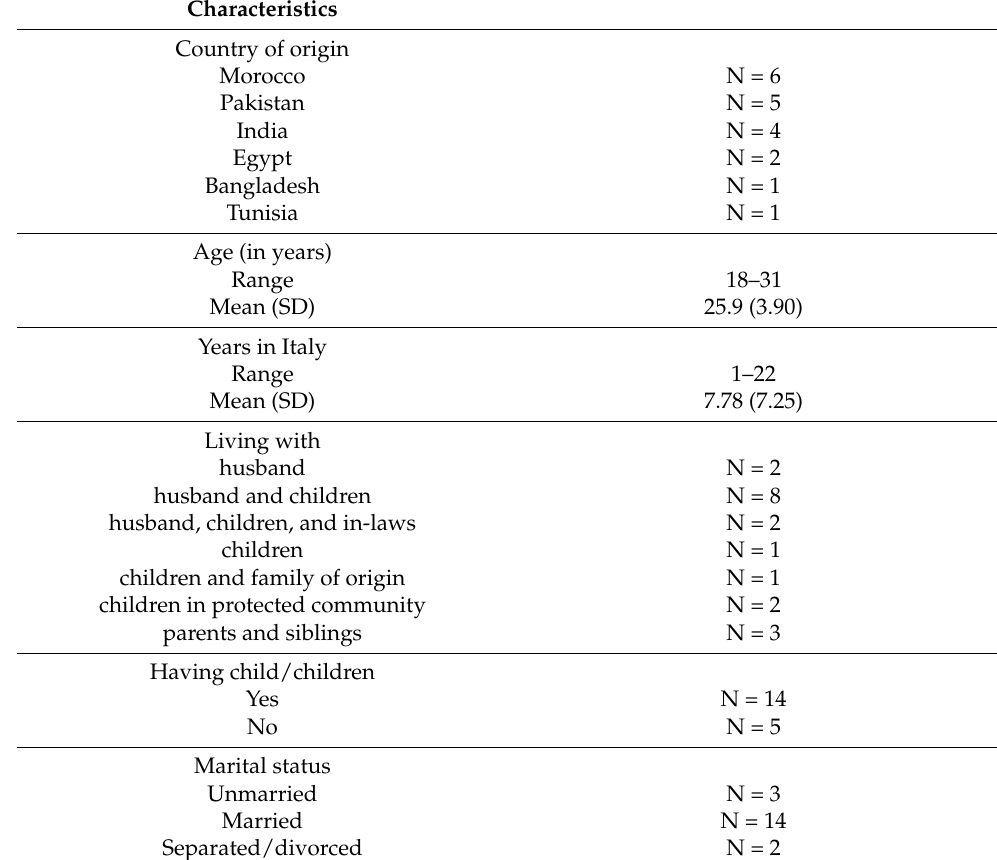
Table 1. Participants’ socio-demographic characteristics (N = 19).